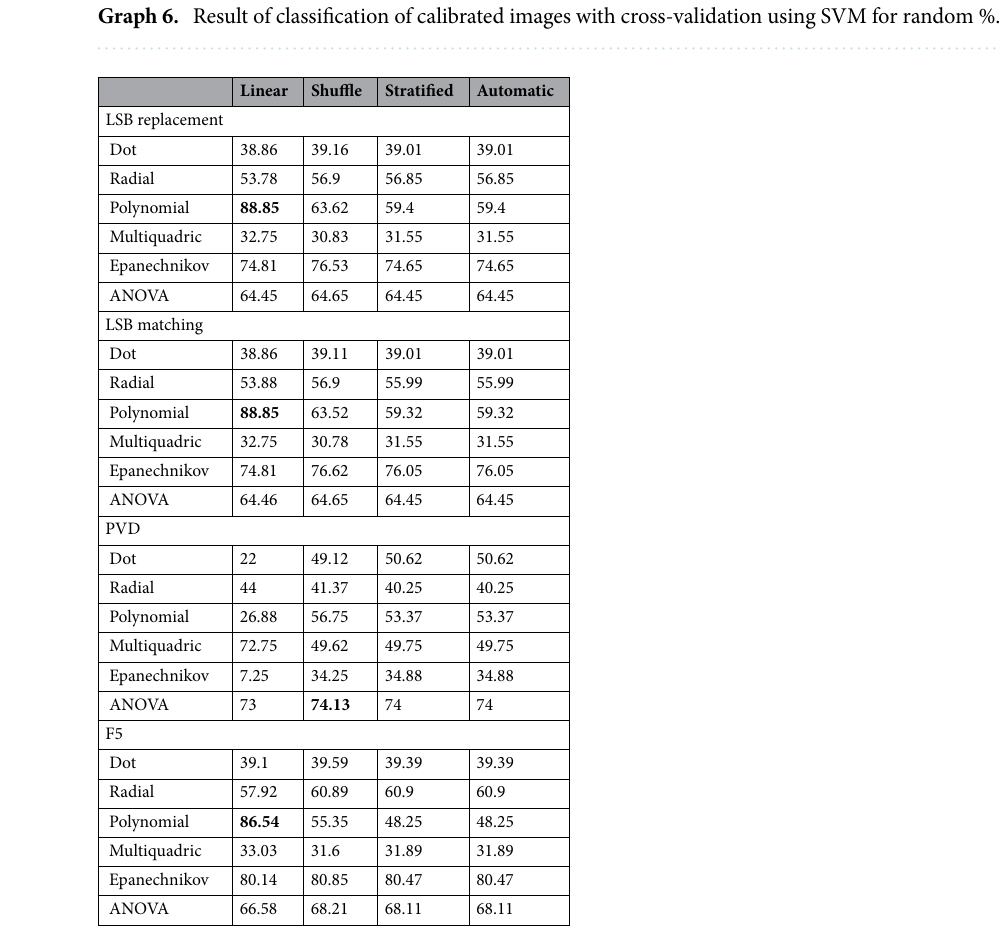
Table 9. Classification of uncalibrated images with cross-validation using SVM-PSO for random %. Significant values are in bold.